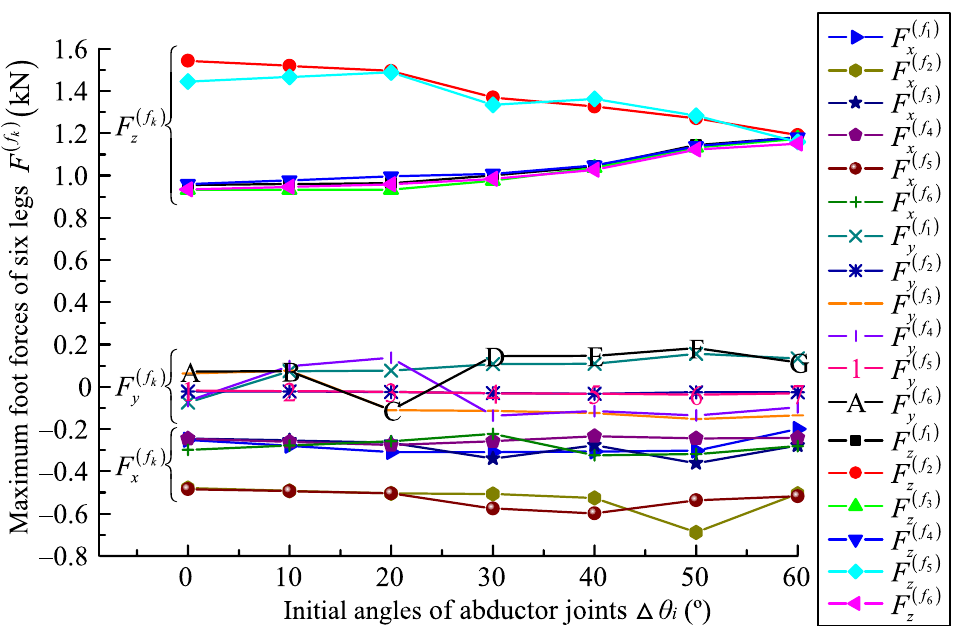
Figure 6 Curves of maximum foot forces with change in initial angle under crab-type tripod